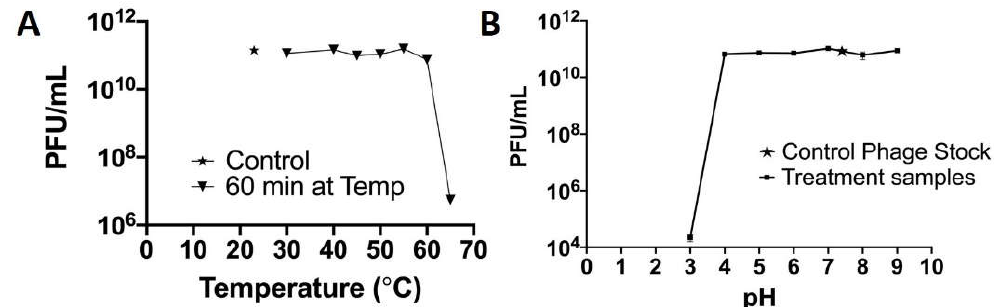
Figure 9. Temperature and pH stability of phage Fulbright.